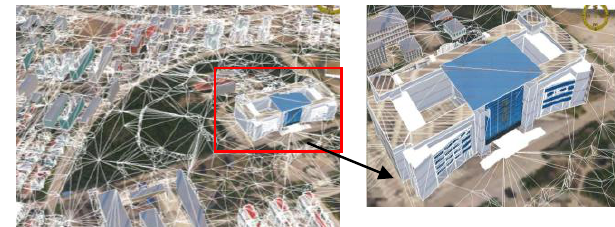
Figure 11. 3D building geometric model